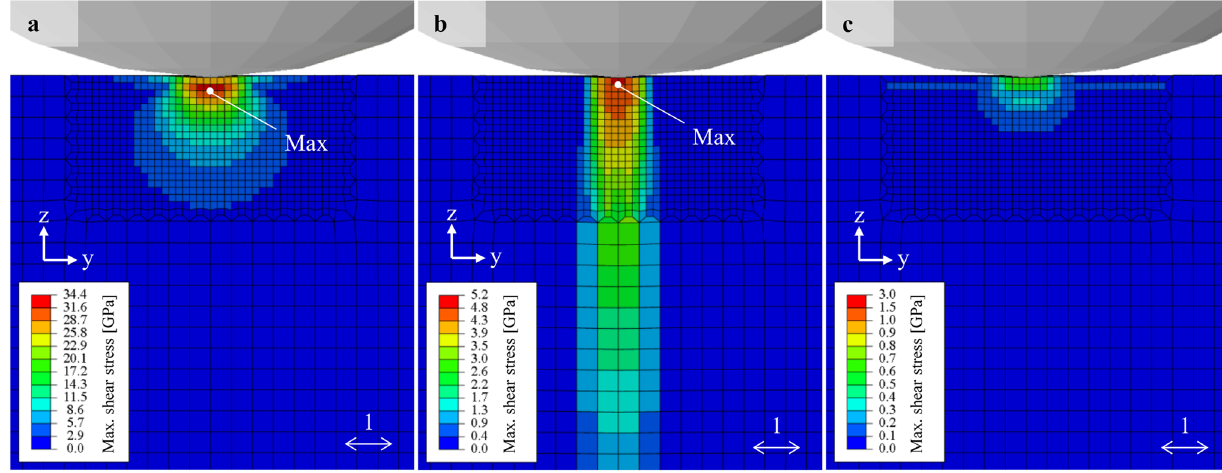
Fig. 8 Relative error of the indentation-derived elastic modulus ( M ) at a tilt angle ( θ ) of 0° at a normalized 2 Rh ) and width height ( H ∕ 2 Rh ) for a the ( W ∕ √ √